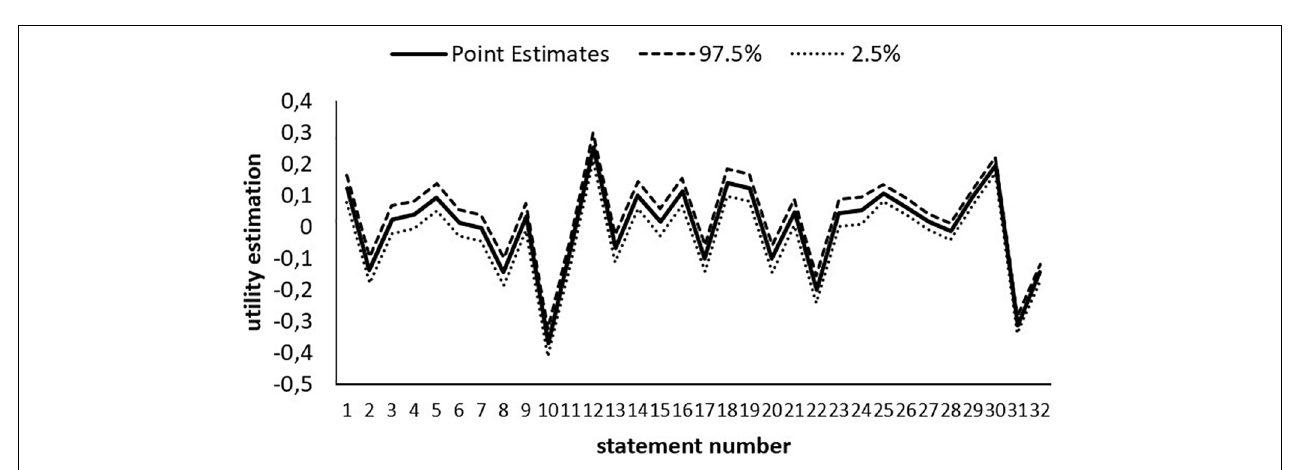
FIGURE 5 | Utility estimates of the statements at the 97.5 and 2.5% quantiles.